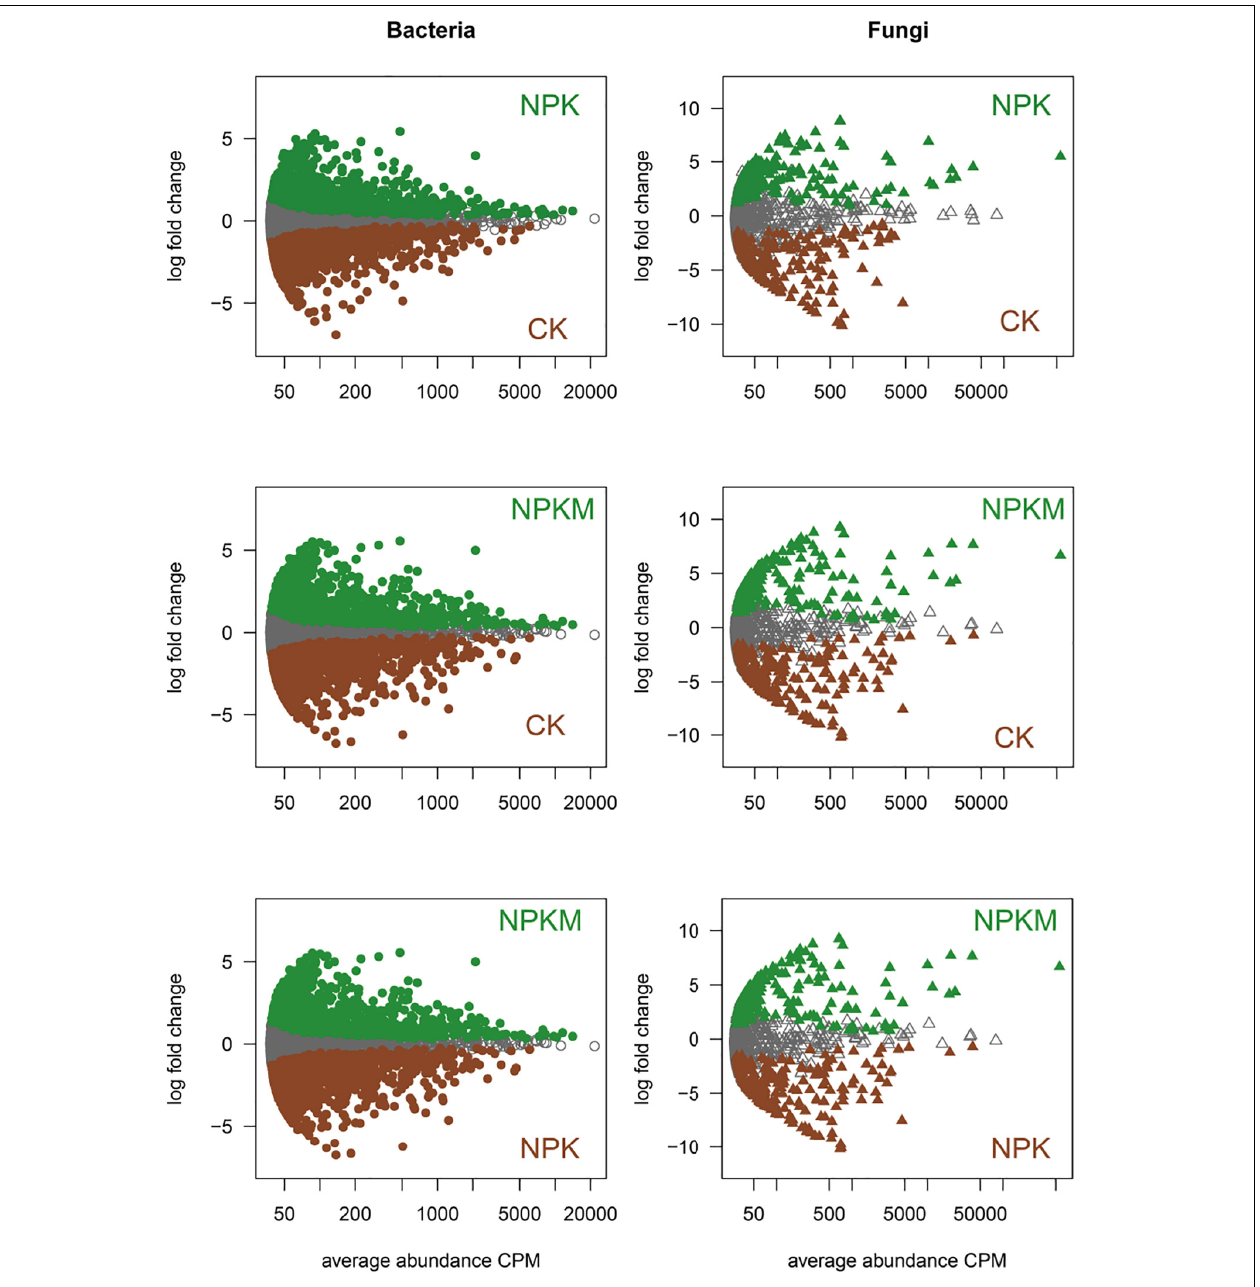
FIGURE 2 | Specific sets of soil microbes under different fertilization regimes. MA plots displayed the abundance patterns of soil bacteria and fungi under CK, NPK, and NPKM treatments. X -axis is average OTU abundance (as counts per million, CPM), and Y-axis is log2–fold change. Non-differentially abundant OTUs are in gray, and fertilization regimes-specific OTUs are colored in darkgreen and brown, respectively (likelihood ratio test, p < 0.05, FDR